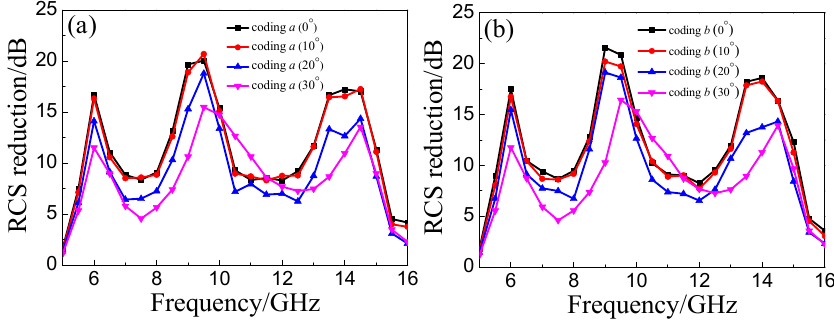
Figure 9. Measured RCS reduction of samples under normal incidence and oblique incidence of 10°, 20°, and 30°: ( a ) coding a ; and ( b ) coding b . Table 1. Comparison of the designed metasurface with similar works presented in the literature. Ref.